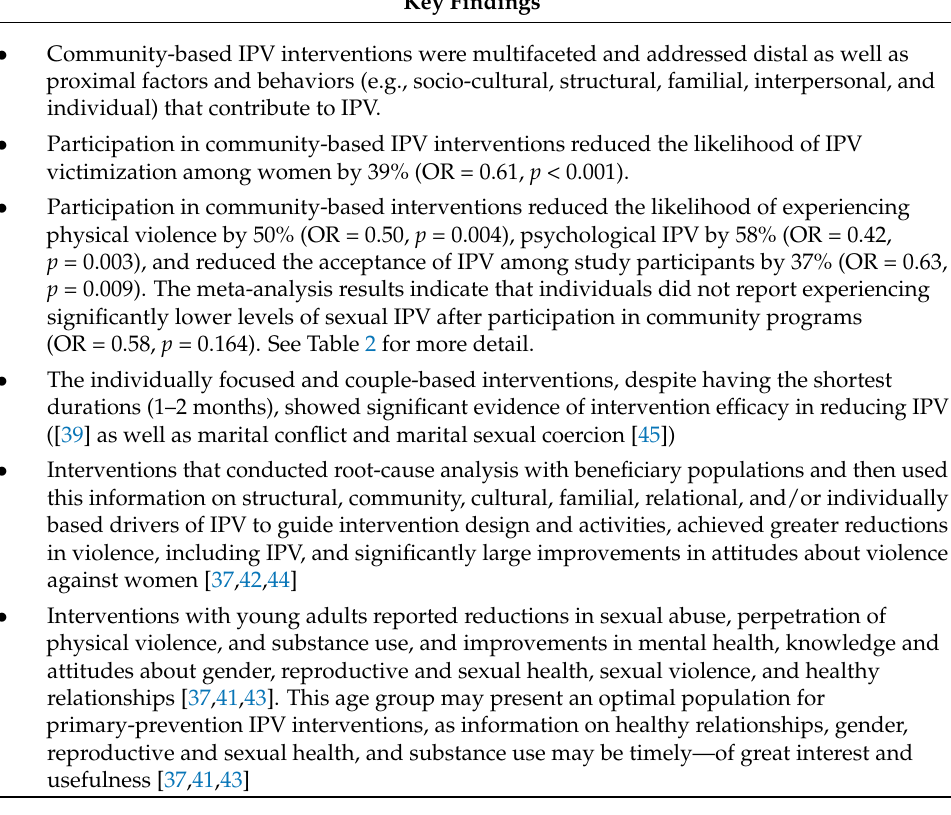
Table 4. Summary of